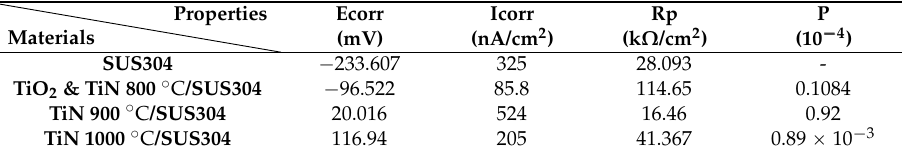
Table 3. Tafel properties of coated and uncoated SUS304 electrodes in an EF